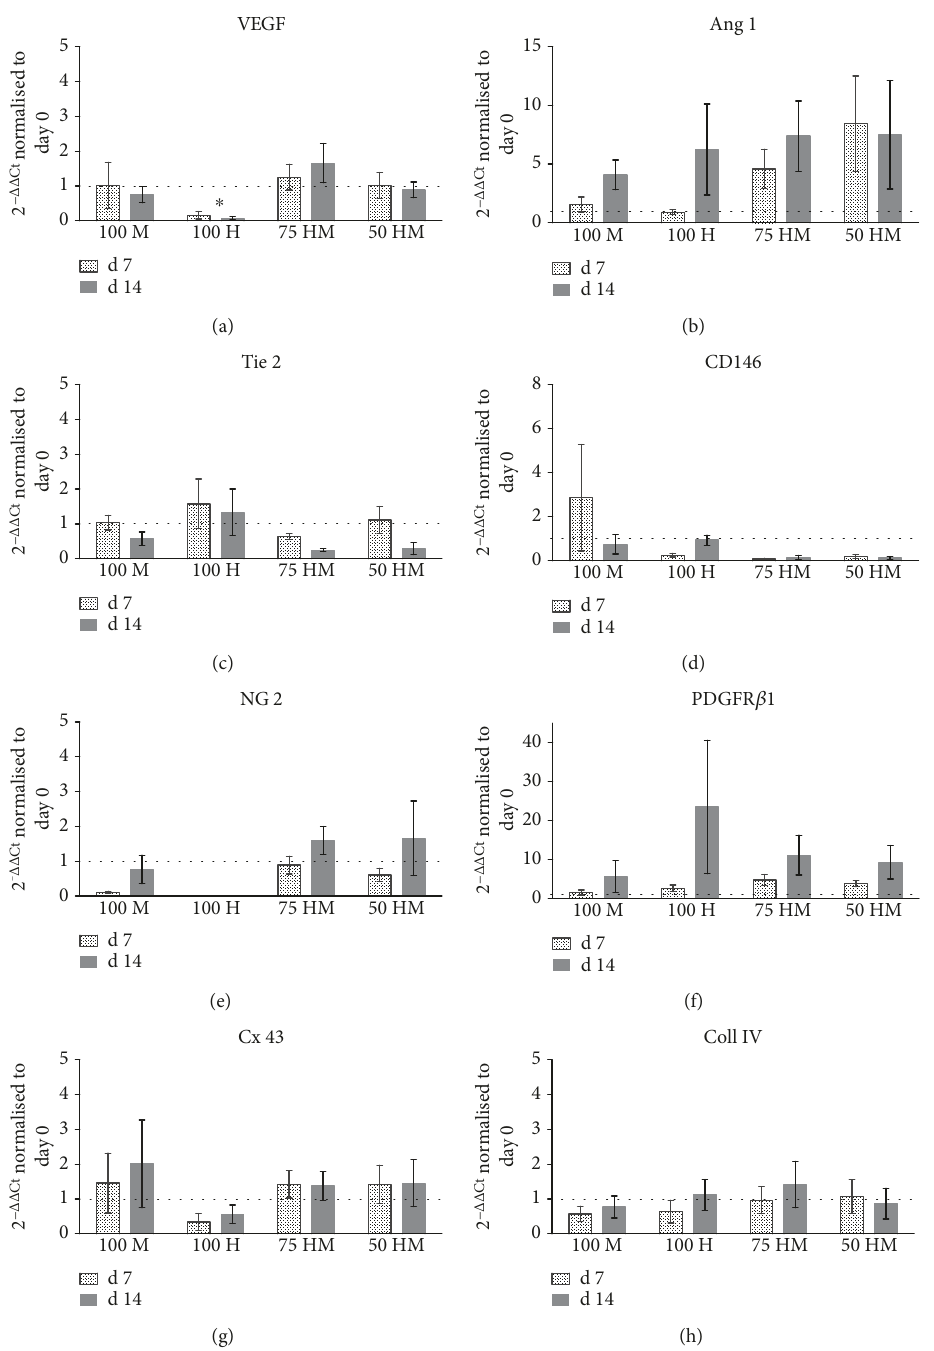
Figure 6: Gene expression of HUVEC and MSC mono- and cocultures in PRP at days 7 and 14. Gene expression (normalized to 18s expression) at day 7 and day 14 is displayed as fold change to day 0. Dashed lines indicate a fold change of 1, that is, unchanged gene expression. MSC monocultures (100M), HUVEC monocultures (100 H), and cocultures 75% HUVECs – 25% MSCs (75 HM) and 50% HUVECs – 50% MSCs (50 HM) were investigated (seeding density: 2.5 × 10 3 cells/ μ l gel). (a) Gene expression of VEGF, showing downregulation in 100H cultures. (b) An upregulation of angiopoetin-1 (Ang 1), a crucial growth factor of angiogenic processes, was detected in all conditions at day 14 as well as in the cocultures on day 7. (c) Gene expression of Tie 2, one of the receptors binding Ang 1. (d – f) Depicted is the expression of pericyte markers CD146, NG 2, and PDGFR β 1, respectively. CD146 was upregulated at day 7 in MSC monocultures (d). At day 7, both cocultures showed a higher NG 2 expression compared to monocultures (e). PDGFR β 1 upregulations were detectable in all cultures at day 14 (f). MSCs upregulated connexin 43 (g), indicating the formation of gap junctions, whereas no di ff erential regulation was observed for collagen IV (h). Two-way ANOVA with Tukey ’ s post hoc test for multiple comparison was applied to test for di ff erences between experimental groups; ∗ p < 0 05 . n = 3